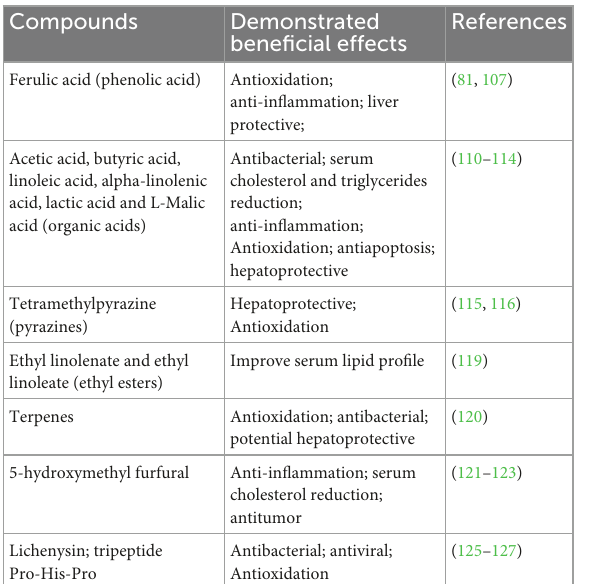
TABLE 4 Abundant and bioactive compound in